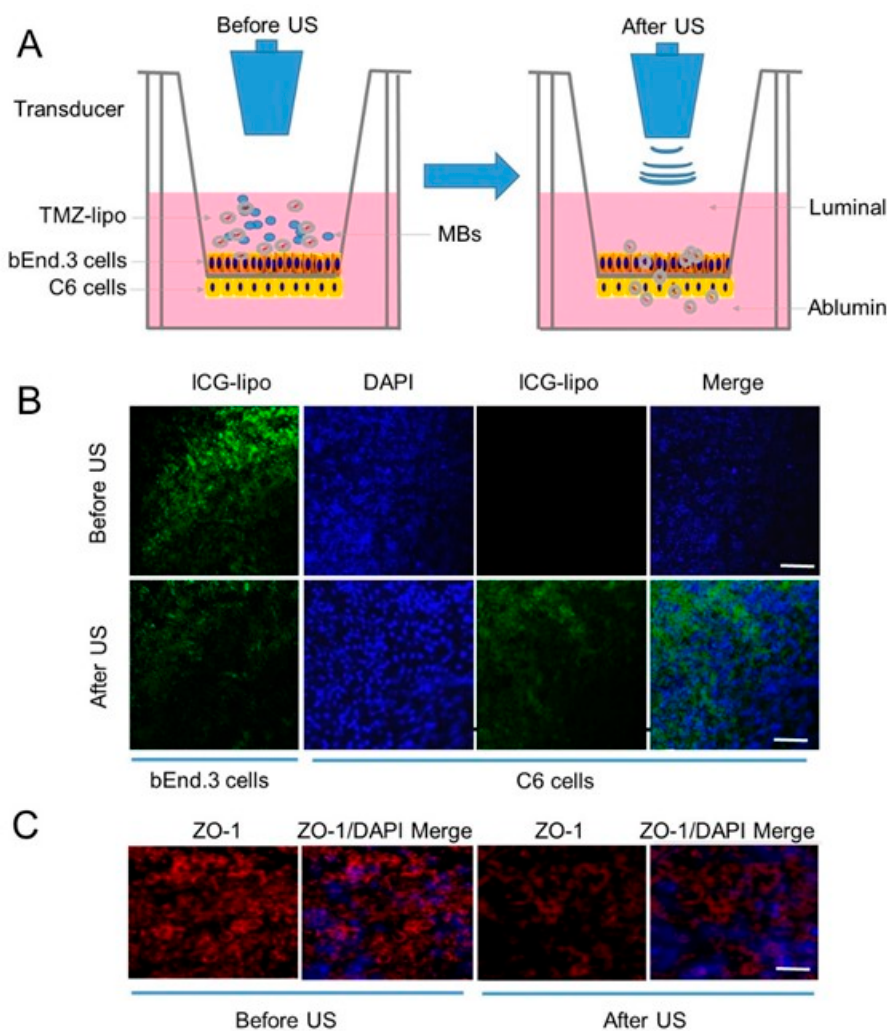
Figure 3. BBB permeability after US in the in vitro BBB model. ( A ) Schematic diagram of the in vitro BBB cell model and US-mediated drug delivery across the BBB. ( B ) The confocal fluorescence microscopic images show fluorescein sodium across the in vitro BBB cell model. Scale bar = 20 µ m. ( C ) The level of TJ-associated protein ZO-1 was detected by immunohistochemical staining. Scale bar = 20 μ m.